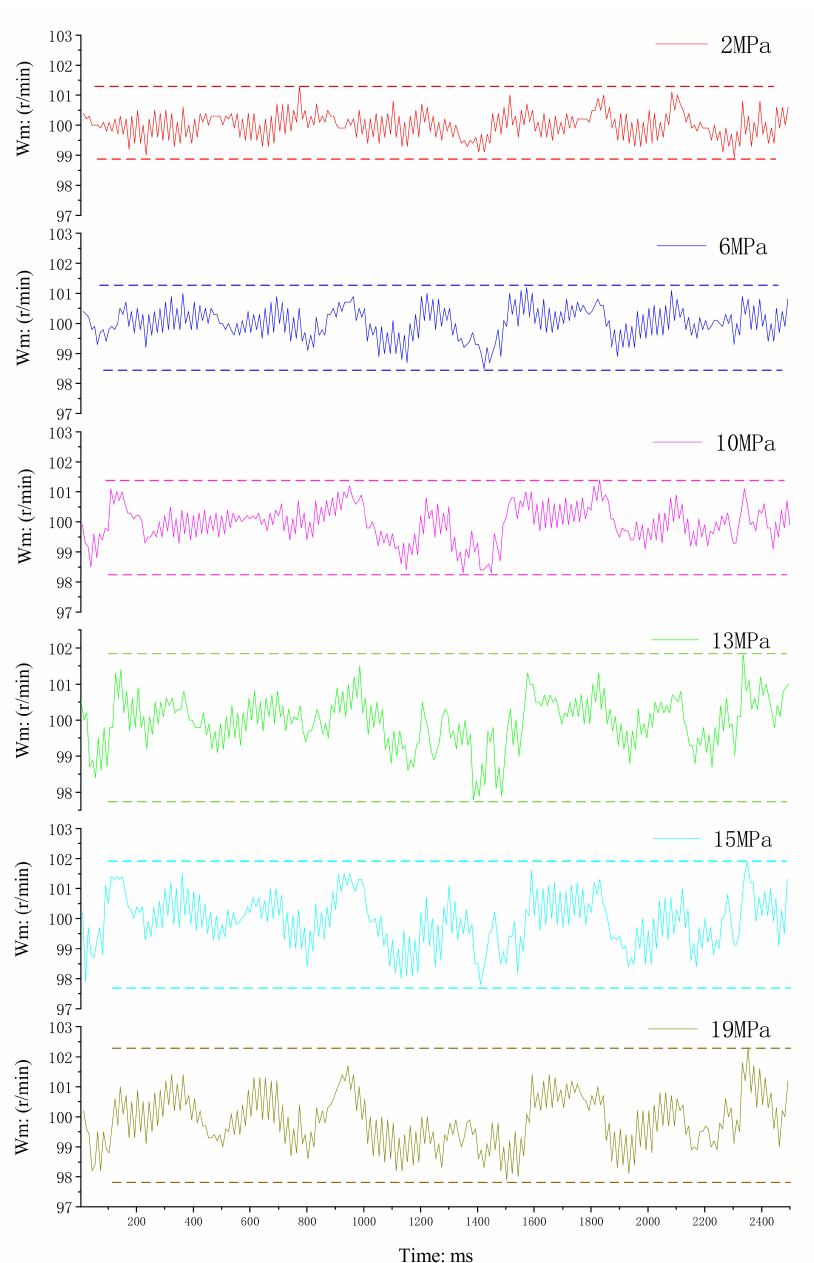
Figure 11. Fluctuation of servo motor speed (constant speed/variable